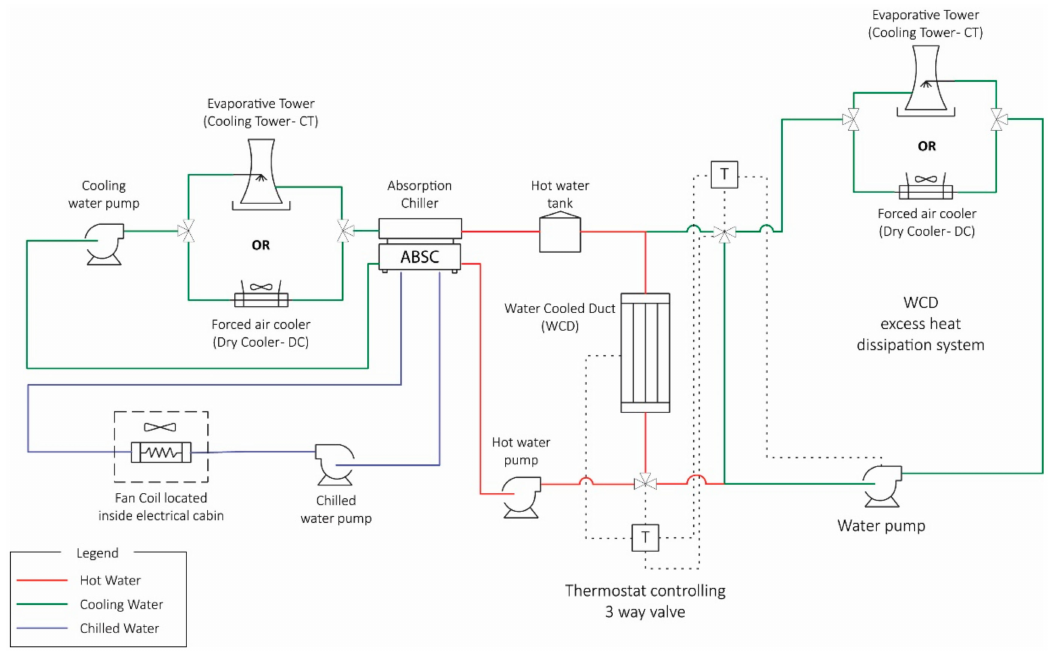
Figure 3. Absorption chiller schematic